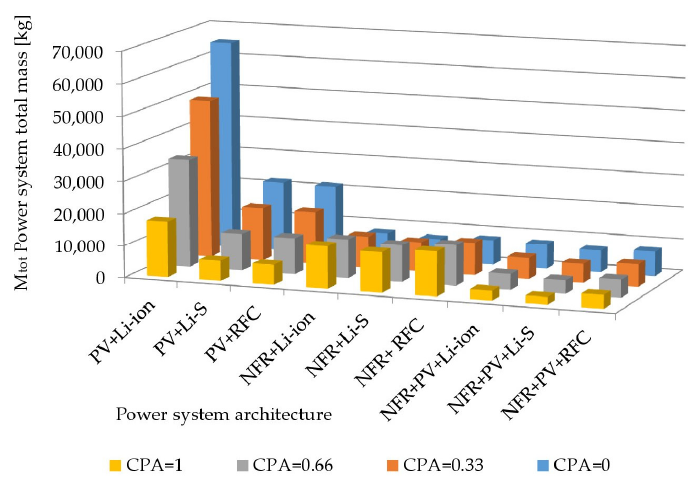
Figure 5. Total mass of the power systems for different power management strategies.